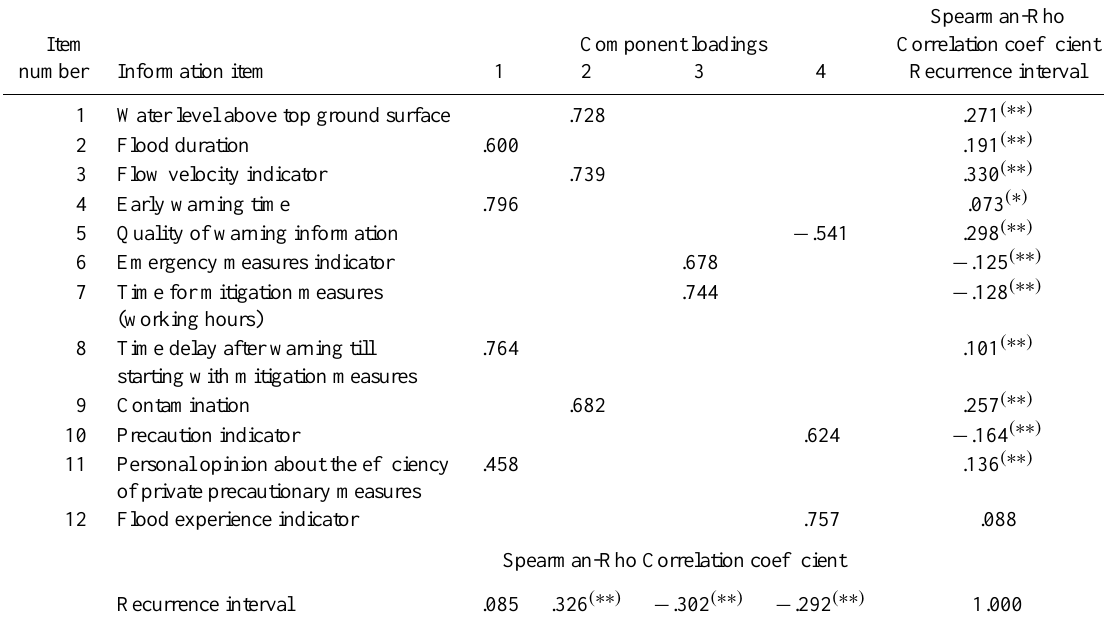
Table 4. Rotated component matrix; contribution of items to four principal components and Spearman-Rho correlation of components, items and recurrence interval.